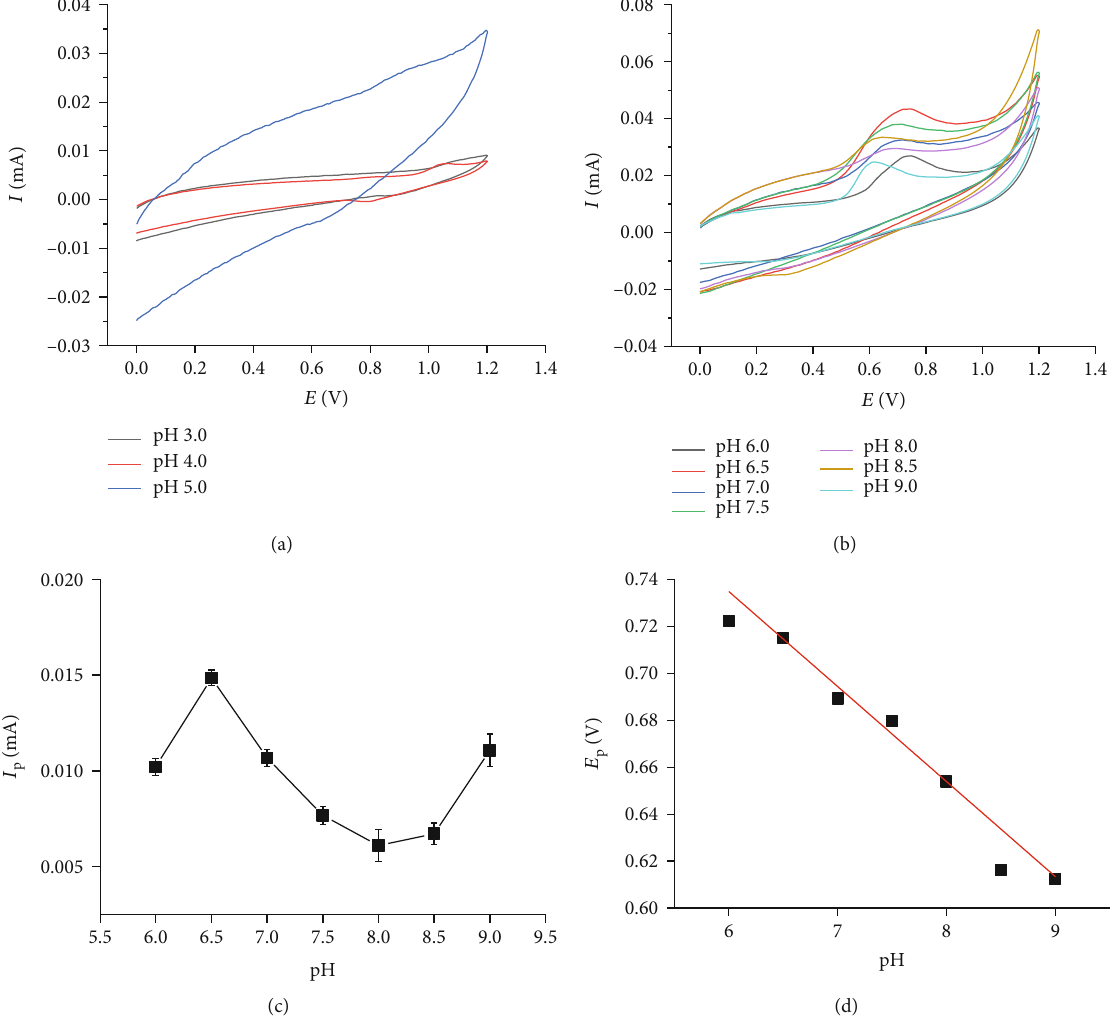
Figure 9: CVs of 5mM DCF with (a) pH3 – 5, (b) pH6 – 9 in 0.2M BRB, (c) I